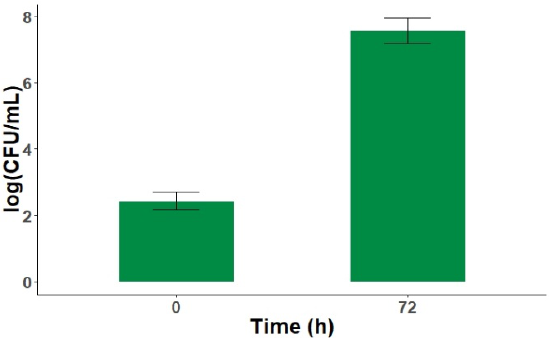
Figure 4. Release of bacteria from alginate beads. The bacterial concentration (log(CFU/mL)) in the saline solution after 72 h of incubation is shown.